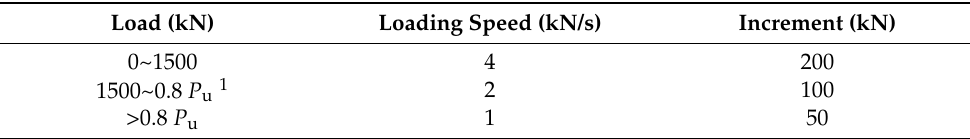
Table 4. Step load testing.